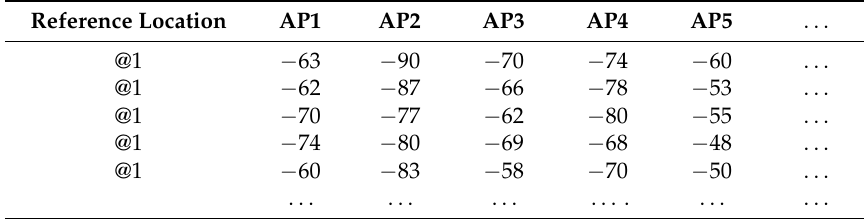
Table 3. Fingerprint